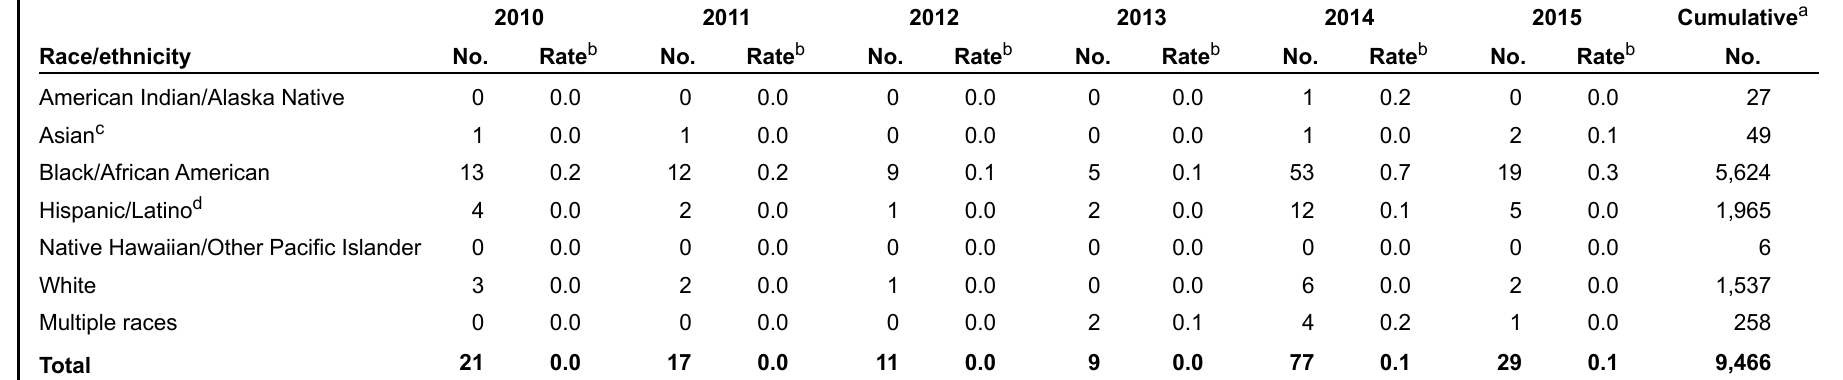
Table 8a. Stage 3 (AIDS) among children aged <13 years, by race/ethnicity, 2010–2015 and cumulative—United States